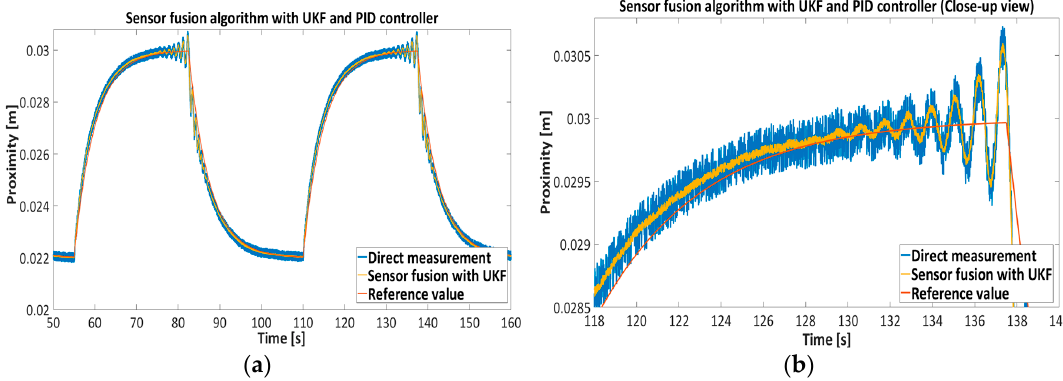
Figure 16. Feedback control of EMAwS with PID controller, comparison between direct proximity measurement and sensor fusion-UKF proximity algorithm.